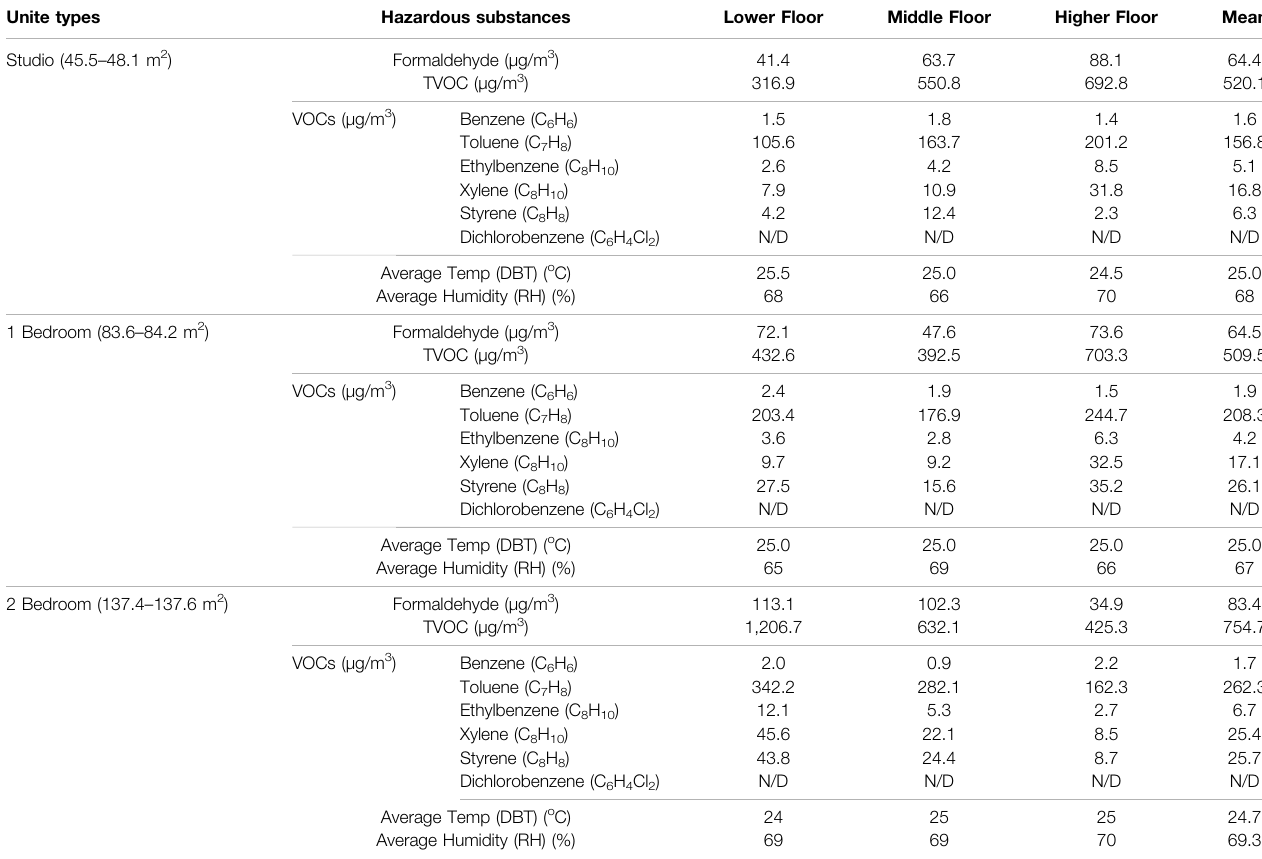
TABLE 5 | Indoor air pollutants measurement for nine different housing units. Unite types Hazardous substances Lower Floor Middle Floor Higher